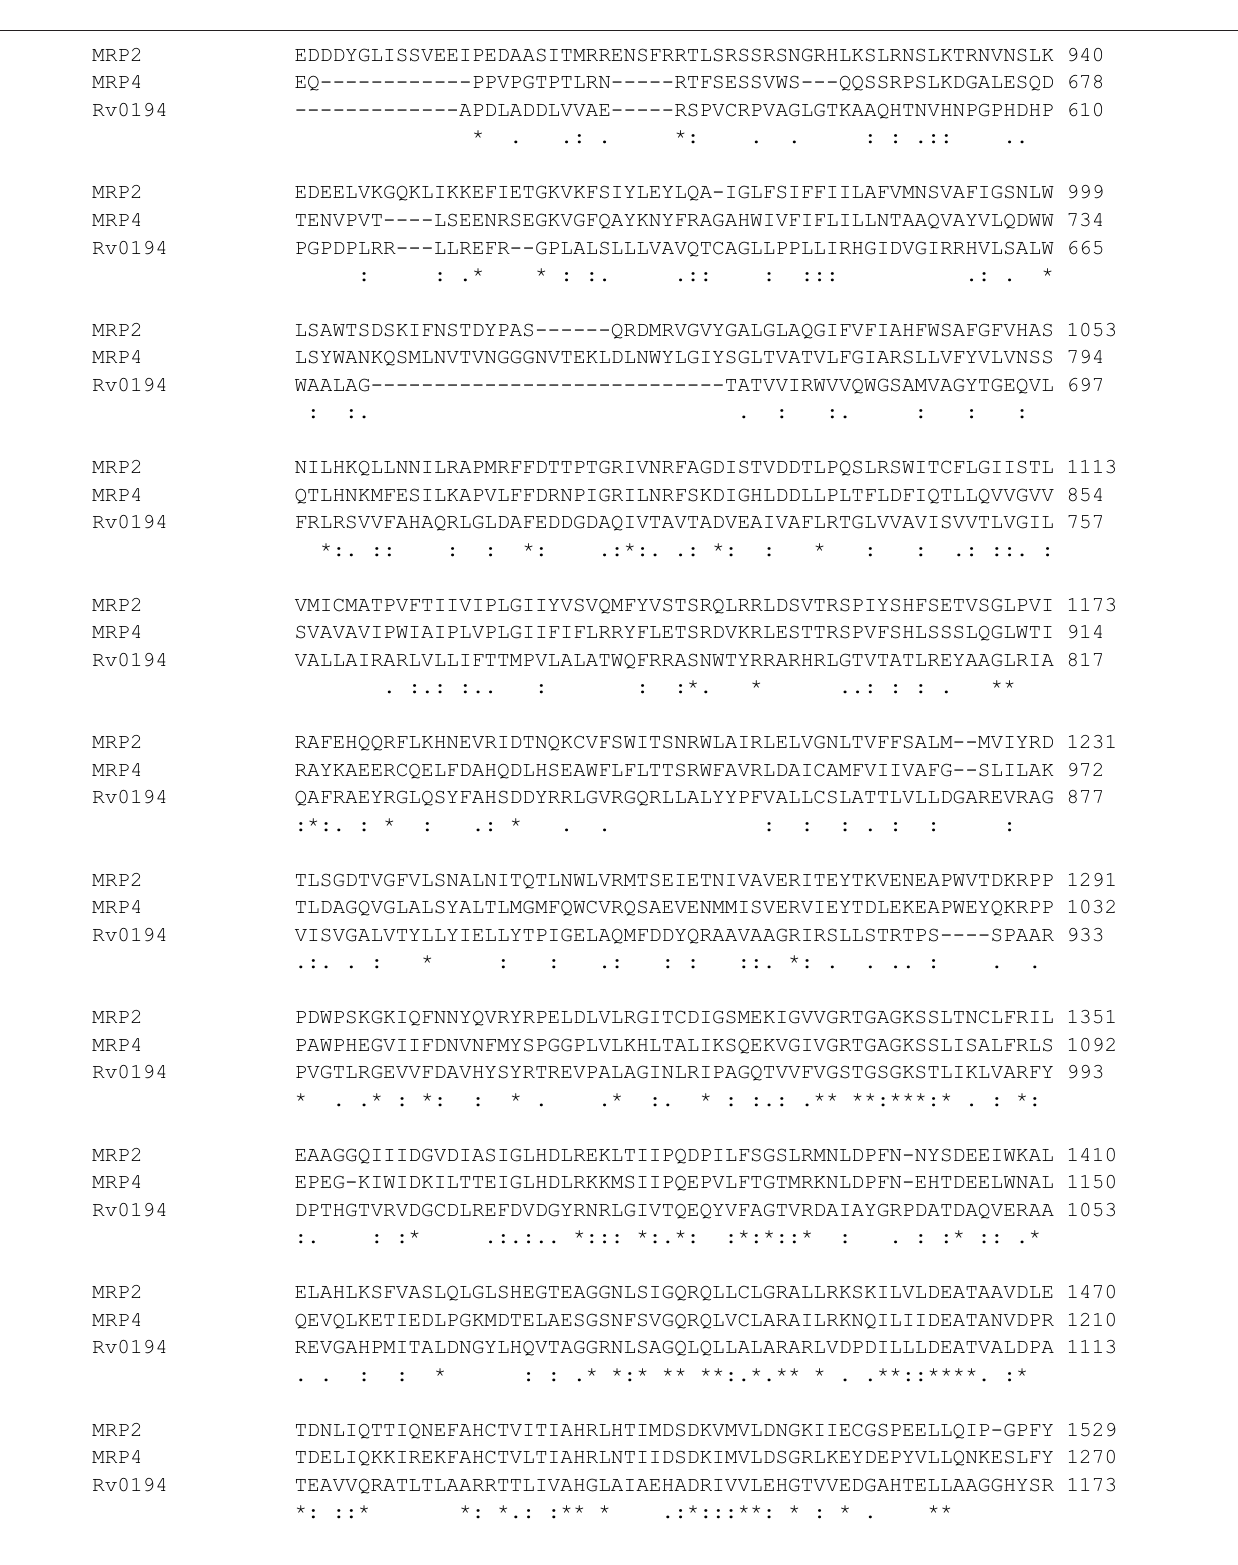
FIGURE 3 | Sequence Alignment of MRP2, MRP4, Rv0194 with ClustalW2. http://www.ebi.ac.uk/Tools/msa/clustalw2/.